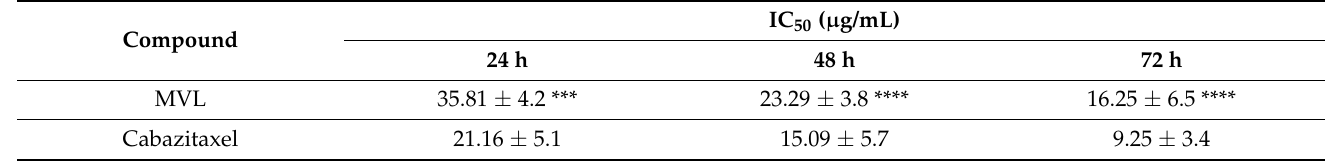
Table 2. Cytotoxicity assessment of MVL against prostate cancer cells (PC3).